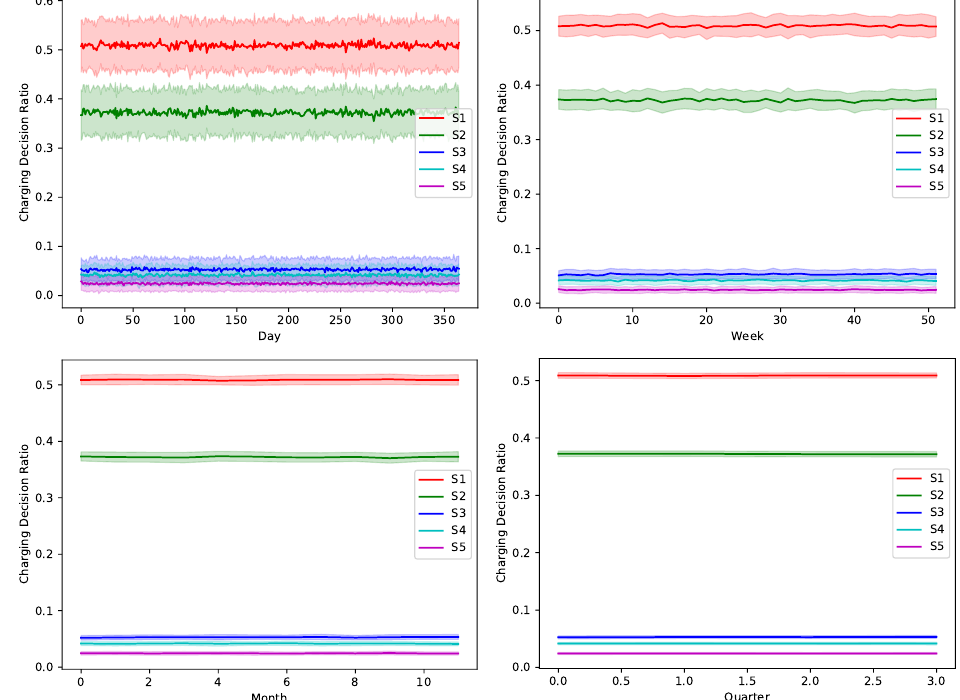
Figure 9. The temporal variation of the adopted charging decision by the greedy algorithm with a global certainty level U 25